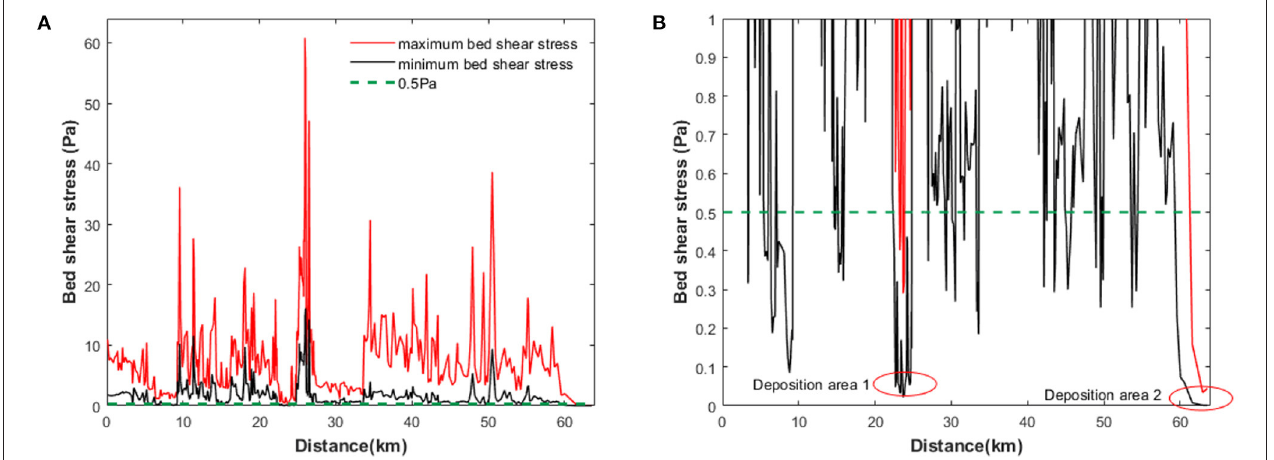
FIGURE 6 | (A) Maximum and minimum bed shear stress simulated by the HEC-RAS Kalamazoo River model at all cross sections in the study domain. (B) A close-up of the bed shear stresses in (A) for the range from 0 to 1 Pa. The green dashed line illustrates one of the critical shear stresses for oil-particle aggregates (OPA) analyzed in the study. The two red circles highlight two dominant potential areas for OPAs to deposit, which are approximately 20 kilometers and 60 kilometers downstream from the starting site,